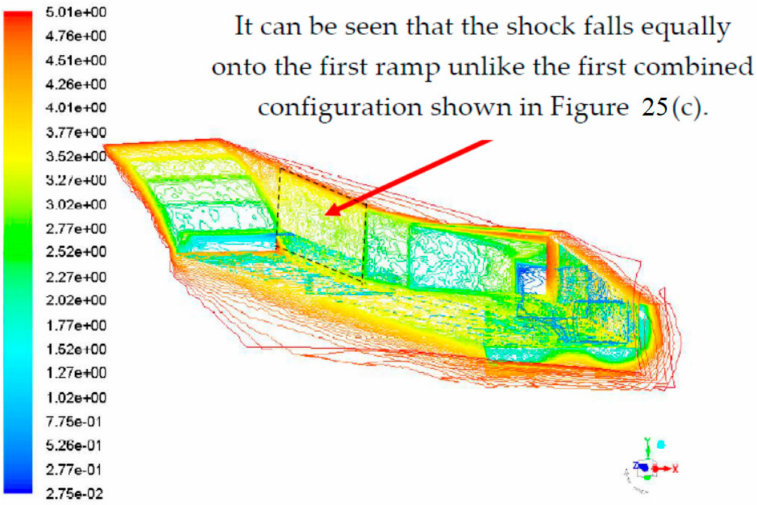
Figure 28. Mach contours for alternative combined cycle engine